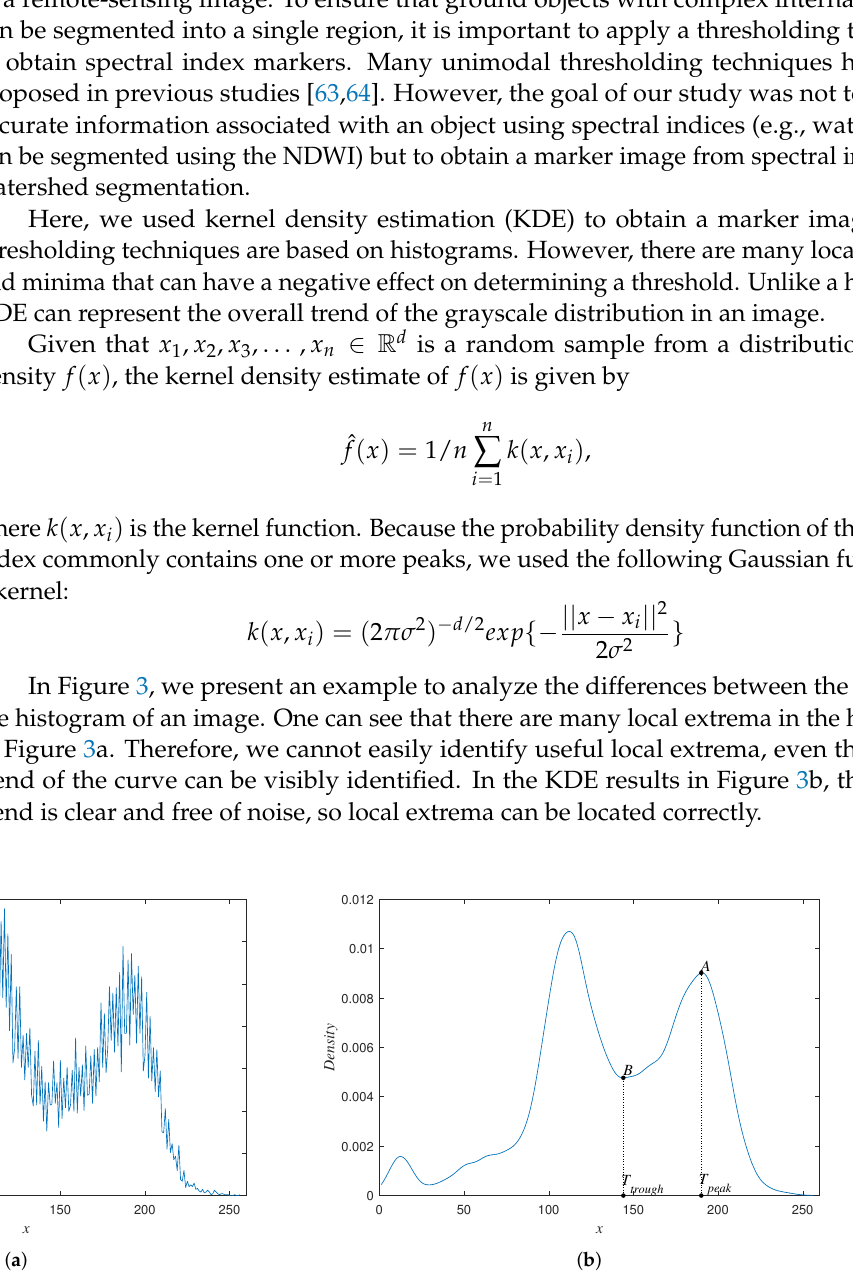
Figure 3. The histogram ( a ) and kernel density estimation (KDE) ( b ) of the image. Because spectral indices are mainly used to enhance the information of the correspond- ing ground objects, a higher value indicates a higher probability of being the corresponding object. Additionally, the grayscale distribution of ground objects is typically normally distributed. Therefore, information on ground objects is relative to the last peak. To identify the last peak, we must find the accurate location of the peak (point A in Figure 3b) and the trough (point B in Figure 3b) on the left of the last peak. The peak A ( x = T peak ) and trough B ( x = T trough ) points can be obtained